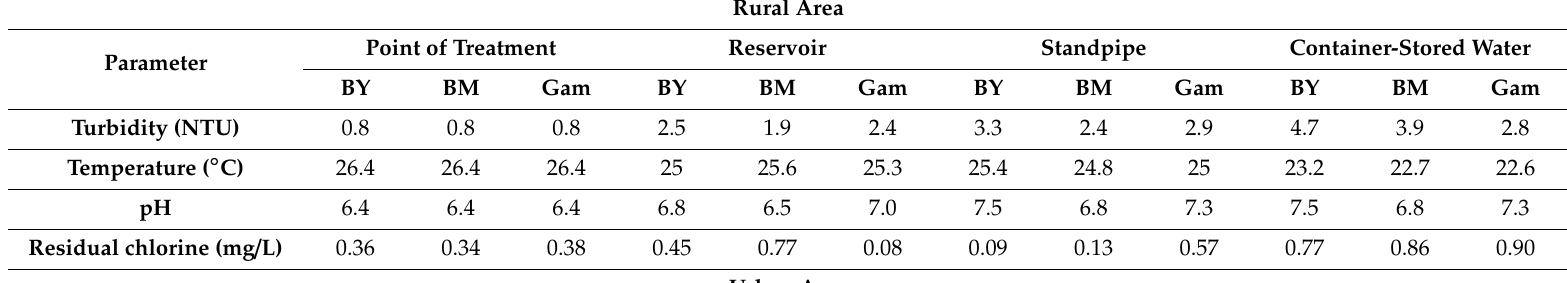
Table 4. Mean turbidity, pH, temperature, and residual chlorine of water samples from the study area. Rural Area Point of Treatment Reservoir Standpipe Container-Stored Parameter